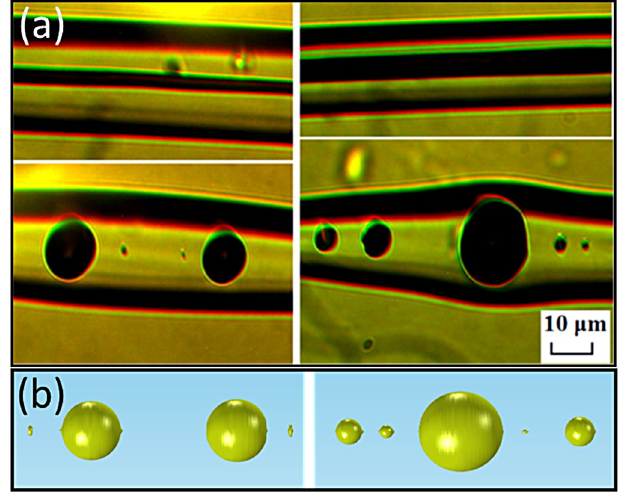
Figure 7. ( a ) Microscope images of formed spheres from fibers with initial core radii of 2 μm (left) and 3 μm (right). Reprinted with permission from [6]. Copyright 2018 American Chemical Society. ( b ) The resulting topology of 2 μm (left) and a 3 μm (right) gold core radii.